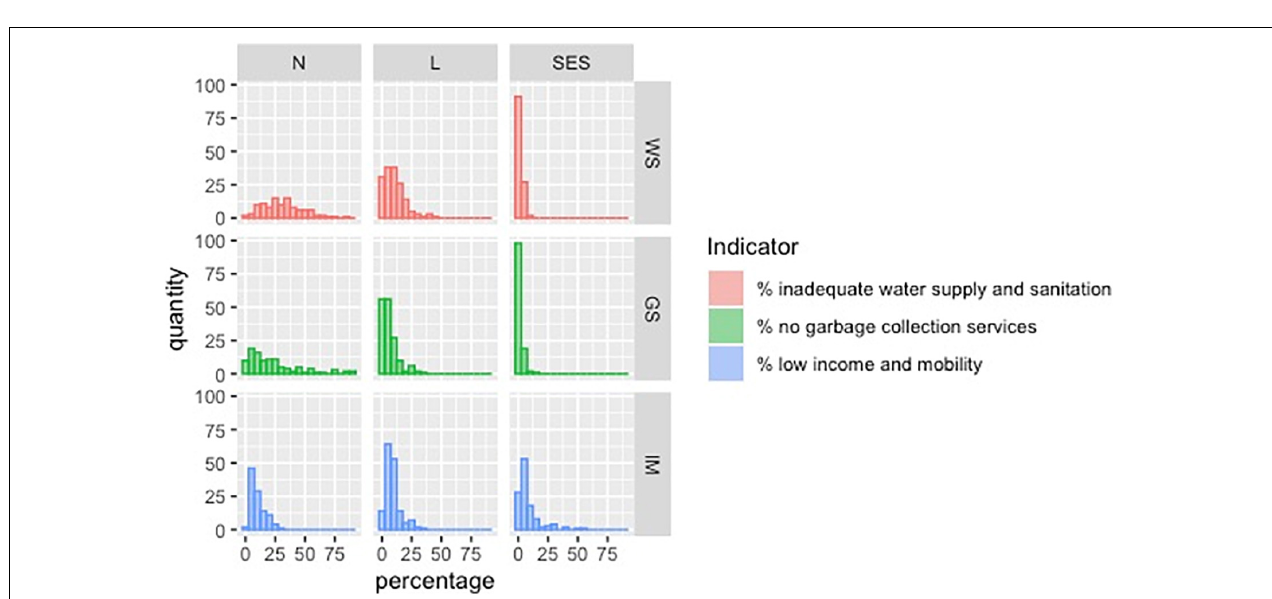
FIGURE 11 | Distribution of the coastal municipalities for their SVI dimensions. Elaborated by the authors with data from IPEA (2020a).